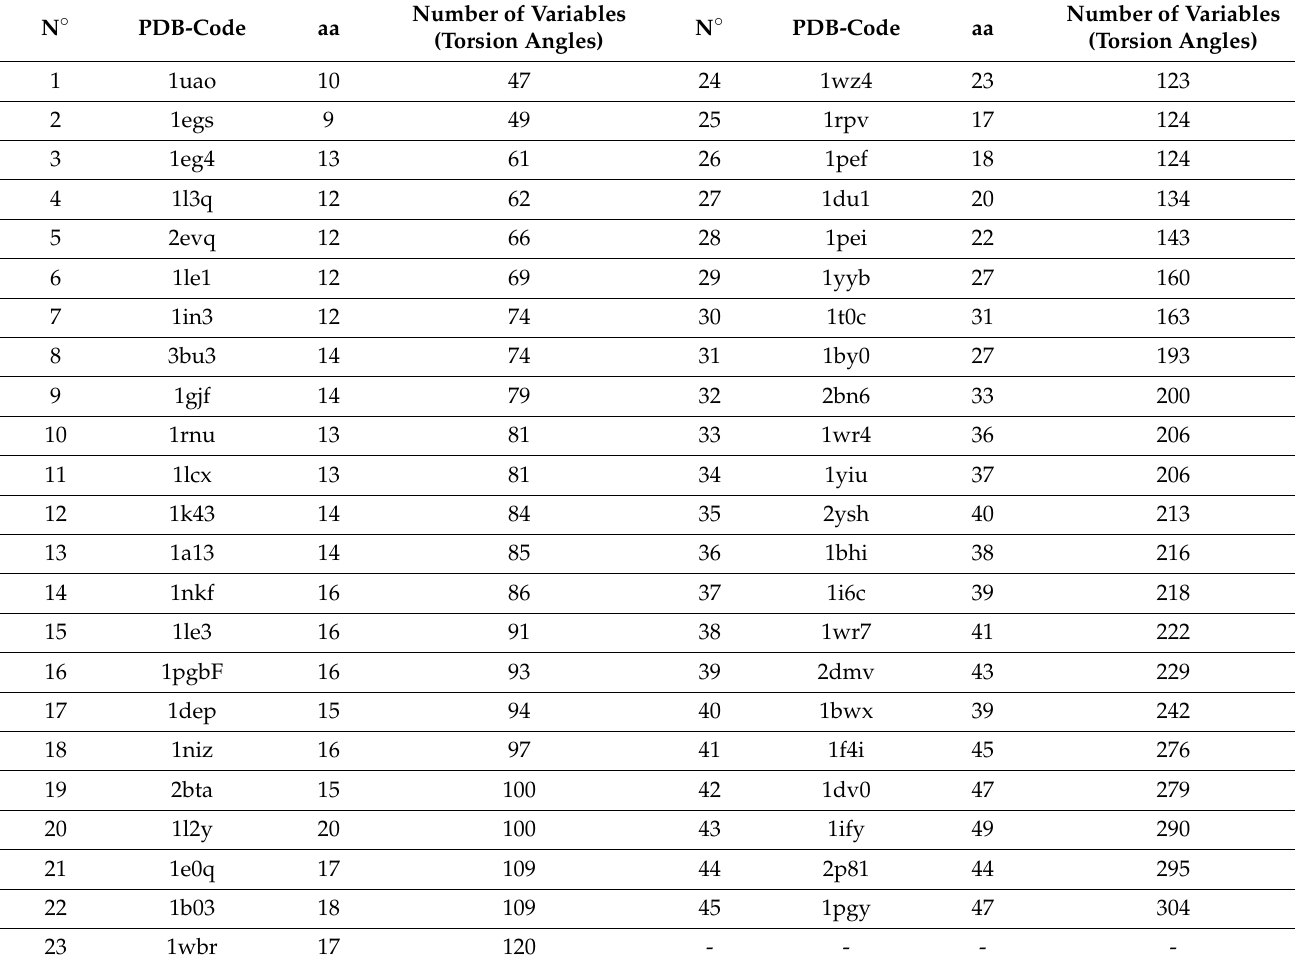
Table 1. Set of instances